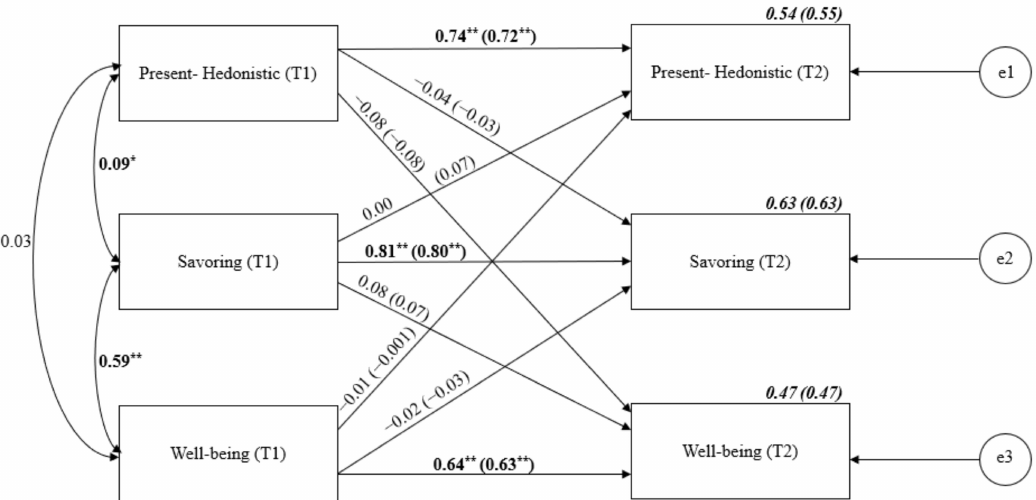
Figure 3. Cross-lagged panel analysis of Present-Hedonistic TP, savoring the moment and well- being. Notes: Path entries are standardized estimates. T1 and T2 indicate the time when data were collected (Time 1 or Time 2, respectively). Estimates for the corresponding model with age and gender controlled are given in brackets. e1–e3 refers to the residual error or error variance that causes response variation in observed variables. * p < 0.05; ** p < 0.01.